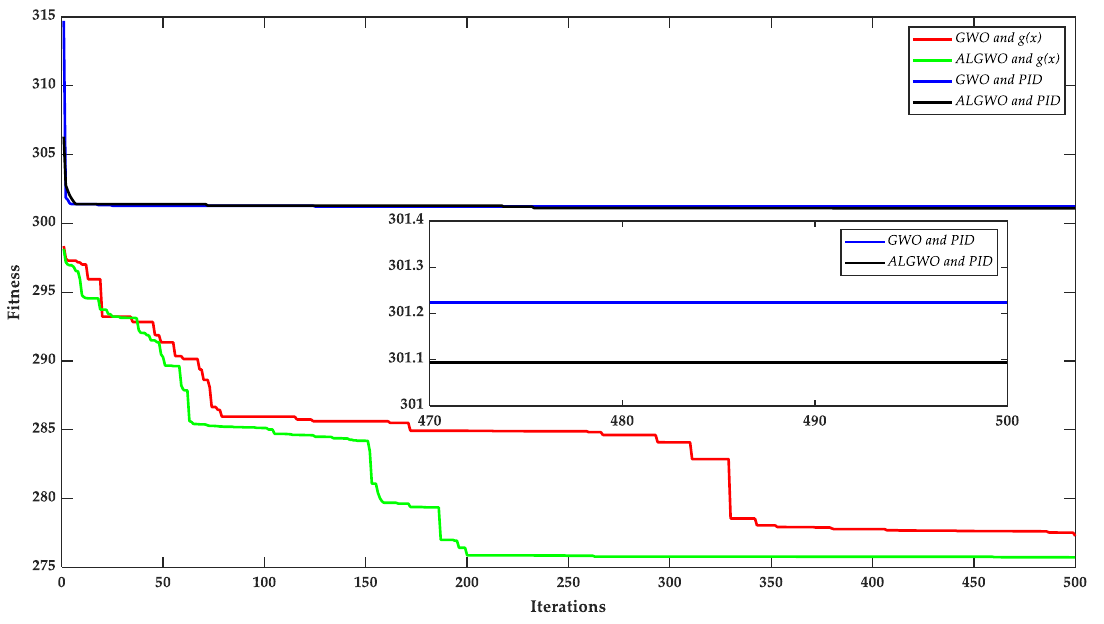
Figure 10. The comparison results of algorithm optimization search on test system 3.